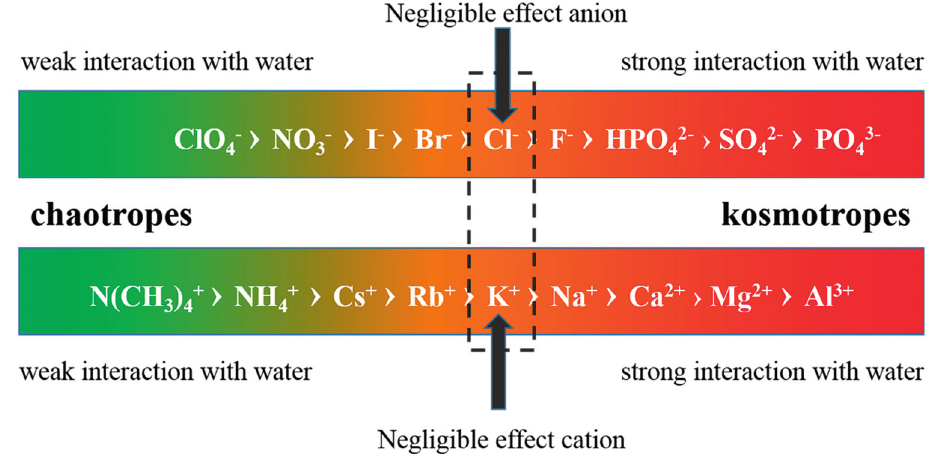
Figure 6. Schematic of relative intensity of interactions of nine anions and nine cations with surrounding water molecules, based on the definition of chaotropes and kosmotropes. The ions on the left side of the two sequences have weaker interactions with water relative to those on the right